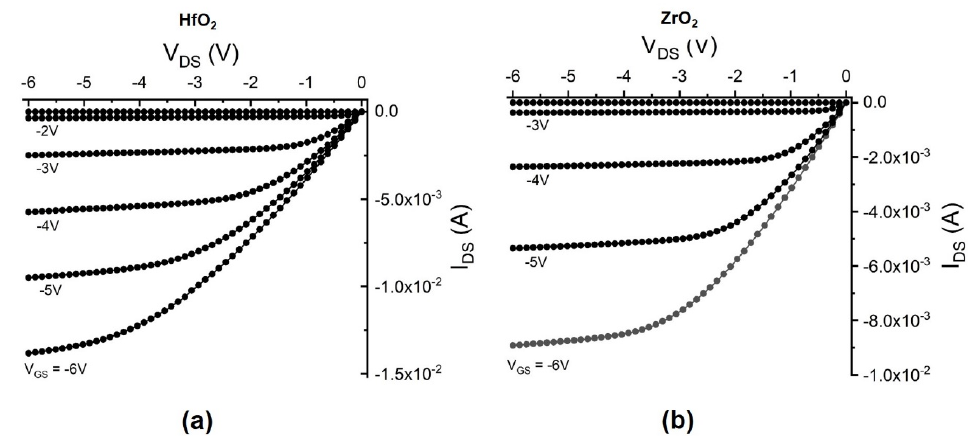
Figure 11. ( a ) Drain-source current (I DS ) versus drain-source voltage (V DS ) and gate voltage (V GS ) for the p-channel field-effect transistors (pFET) fabricated with the HfO 2 thin film as the gate oxide; ( b ) Drain-source current (I DS ) versus drain-source voltage (V DS ) and gate voltage (V GS ) for the pFET fabricated with the ZrO 2 thin film as the gate oxide.